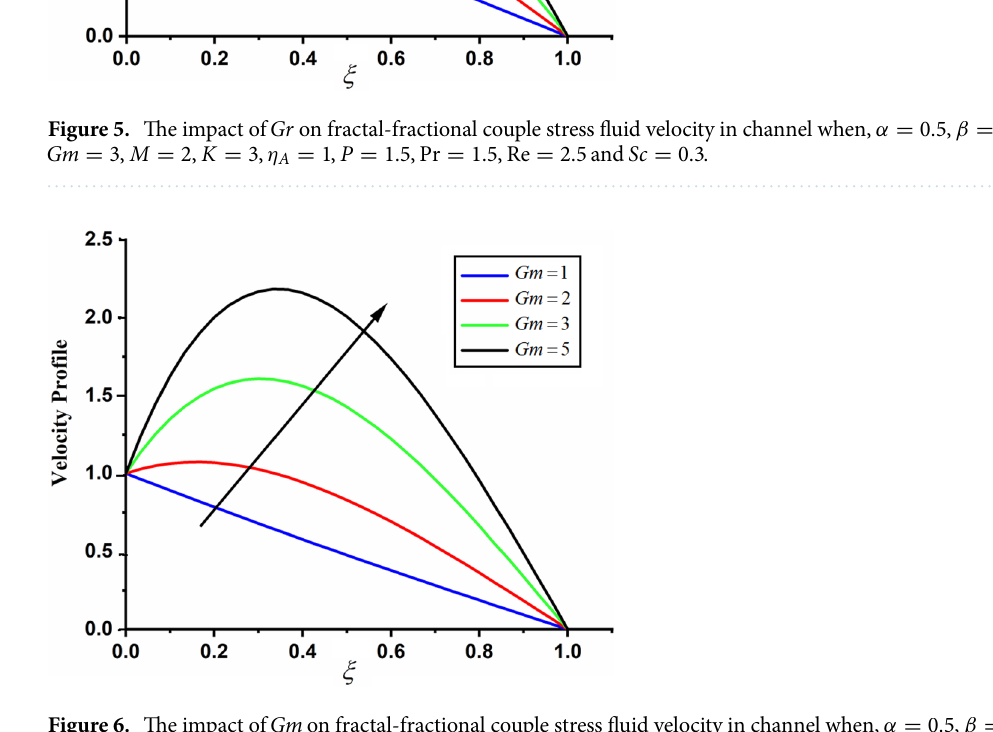
Figure 6. The impact of Gm on fractal-fractional couple stress fluid velocity in channel when, α = 0.5 , β = 0.5 , Gr = 2 , M = 2 , K = 3 , η A = 1 , P = 1.5 , Pr = 1.5 , Re = 2.5 and Sc = 0.3